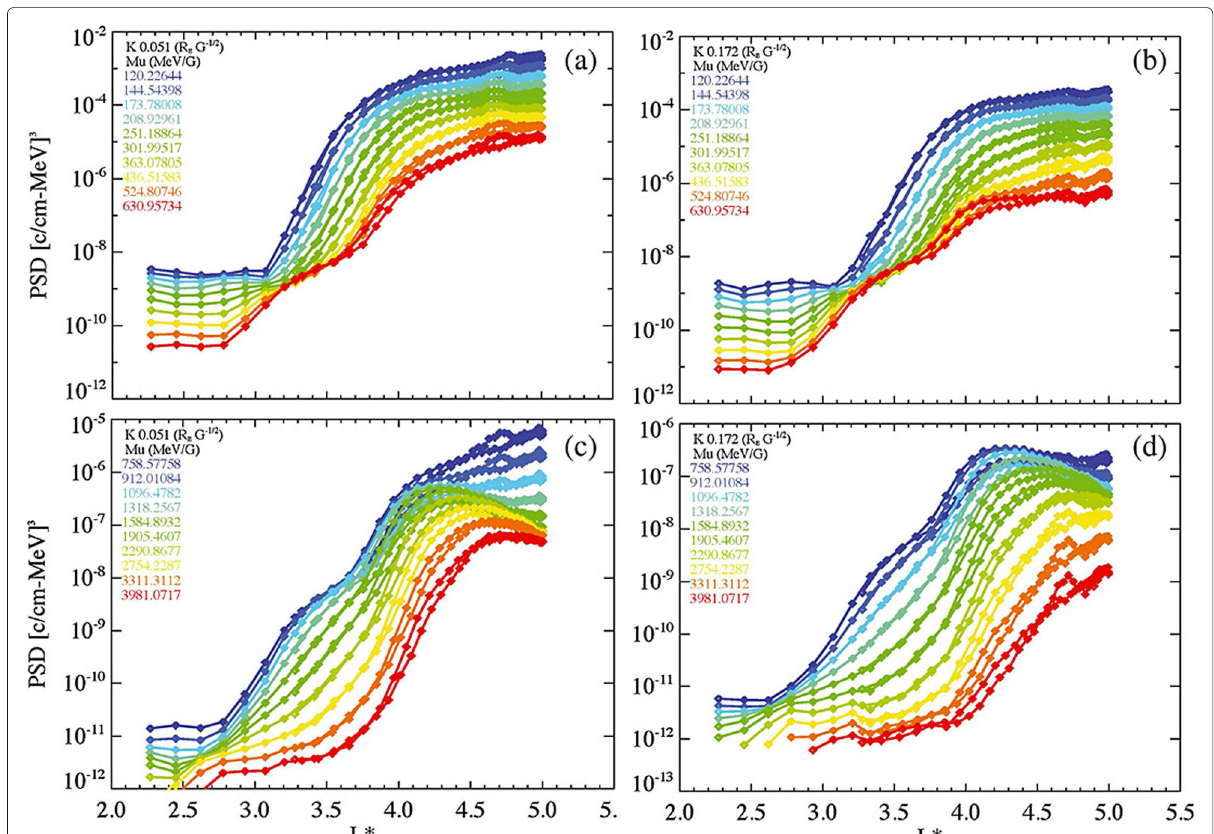
Fig. 14 Radial profiles of electron phase space density obtained from measurements by Van Allen Probe A of pitch angle-resolved energetic electrons. The panels show for two values of the second adiabatic invariant, K multiple values of PSD for μ , the first invariant as color coded lines. The numerical values are listed in the legend accompanying the figures (reproduced from Kanekal et al.